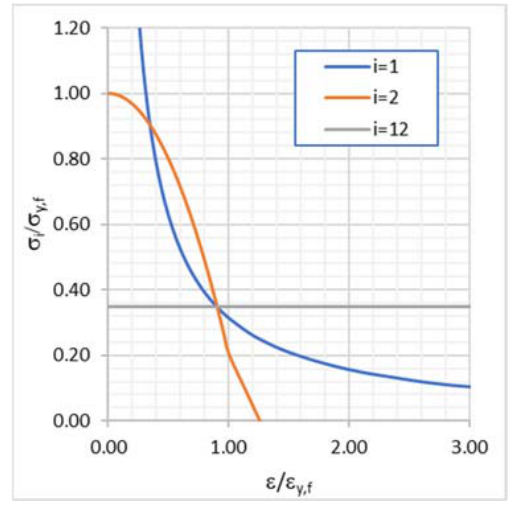
Figure 4. Descriptors of Equation (8).